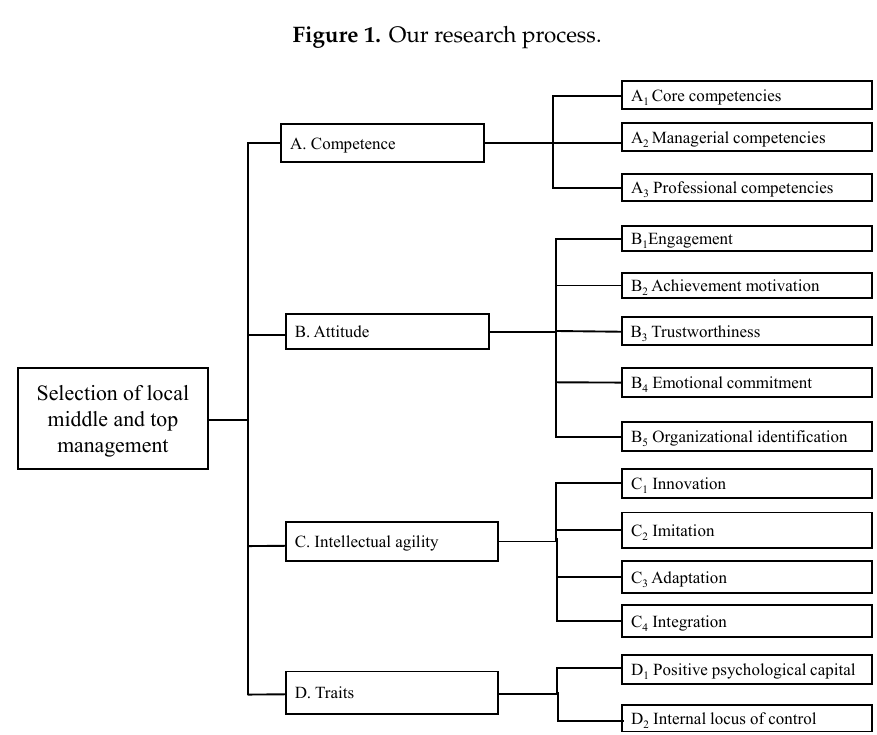
Figure 2. The initial dimensions and criteria framework.